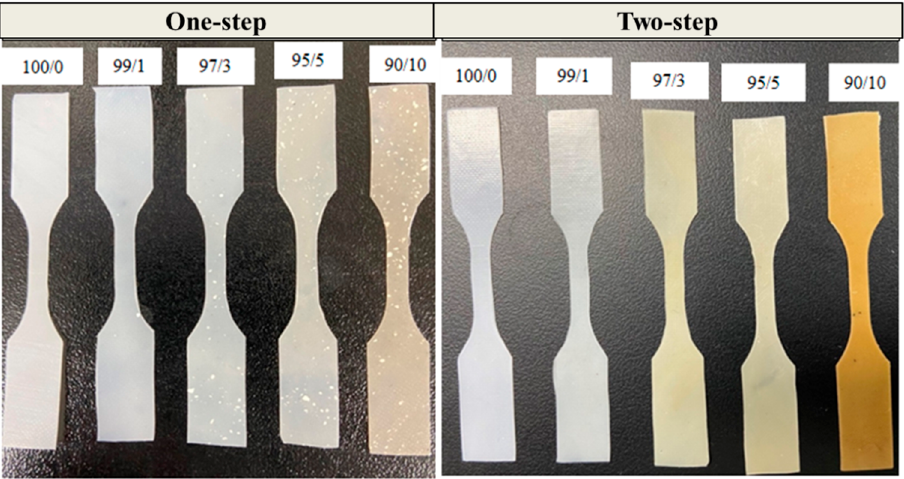
Figure 5. Digital photographs of dog-bone shaped PBS/CNF composites prepared by one-step and two-step processes.